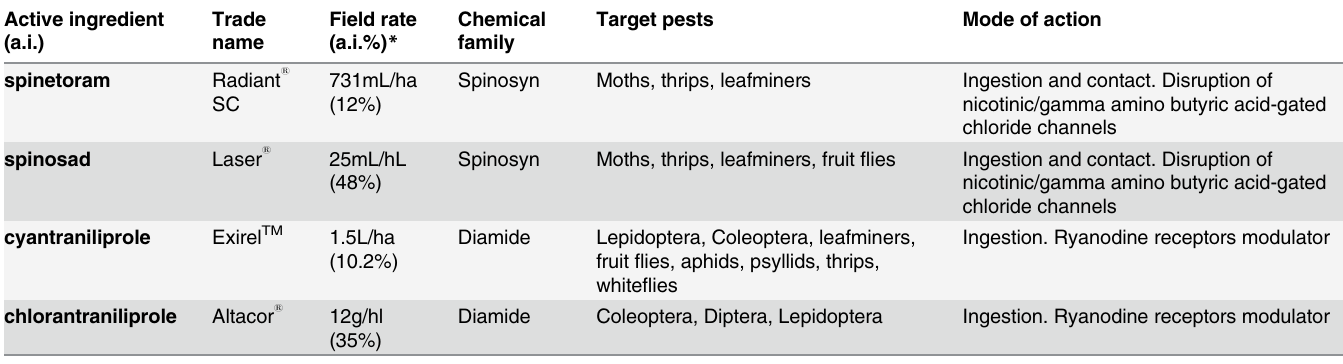
Table 1. Tested insecticides. Active ingredient